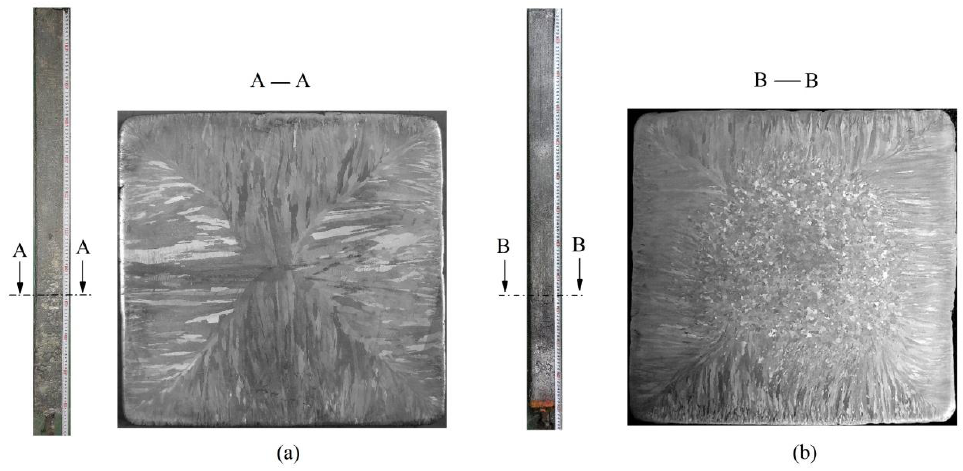
Figure 3. Macrostructure morphology of the billet cross-section: ( a ) Set I and ( b ) II.